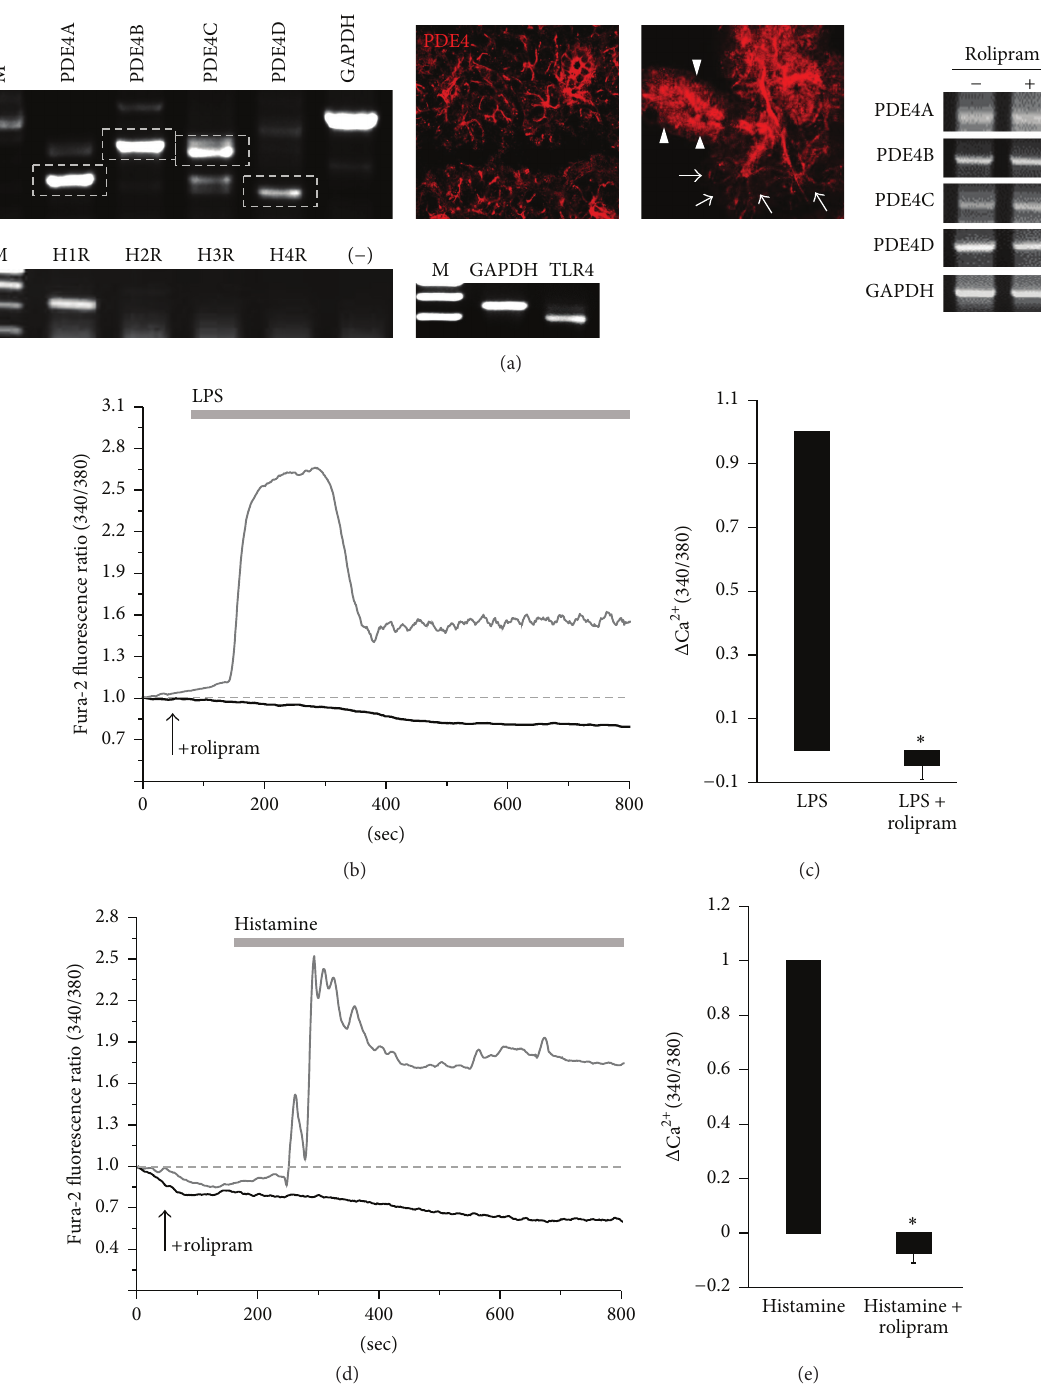
Figure 1: Rolipram inhibits LPS- and histamine-induced [ Ca 2+ ] i signaling in mouse SMG acinar cells. (a) mRNA expression of PDE4 subfamily 4A through 4D and localization of PDE4 (red) in SMG tissue (left) and isolated cells (right). Arrow heads (duct) and arrows (acini). mRNA expression of TLR4 and histamine receptors (H1R to H4R) in SMG cells and expression of PDE4A through 4D in the presence of rolipram. (b) Changes in [ Ca 2+ ] i induced by 20 𝜇 g/mL LPS (gray trace) and pretreatment with 10 𝜇 g/mL rolipram (black trace including arrow which indicates rolipram-stimulated time course) in SMG acinar cells. The traces are averaged trace ( 𝑛 = 4 ). The upper bars indicate theextracellular solutions applied tothecells. (c) Analysis of LPS-induced maximum [ Ca 2+ ] i peak as determined using R340/380 fluorescence ratios ( ∗ 𝑃 < 0.01 ) and means ± SEMs. (d) Changes in [ Ca 2+ ] i induced by 100 𝜇 M histamine (gray trace) and pretreatment with 10 𝜇 g/mL rolipram (black trace including arrow which indicates rolipram-stimulated time course) in SMG acinar cells. The traces are averaged trace ( 𝑛 = 3 ). The upper bars indicate the extracellular solutions applied to the cells. (e) Analysis of histamine-induced maximum [ Ca 2+ ] i peak as determined using R340/380 fluorescence ratios ( ∗ 𝑃 < 0.01 ) and mean ±